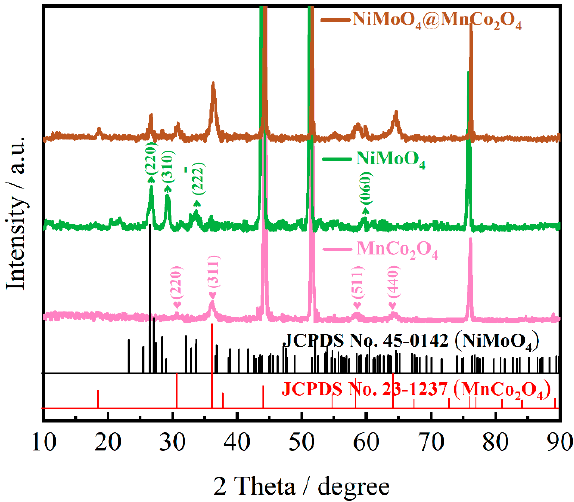
Figure 2. XRD patterns of NiMoO 4 , MnCo 2 O 4 and NiMoO 4 @MnCo 2 O 4 electrode materials.